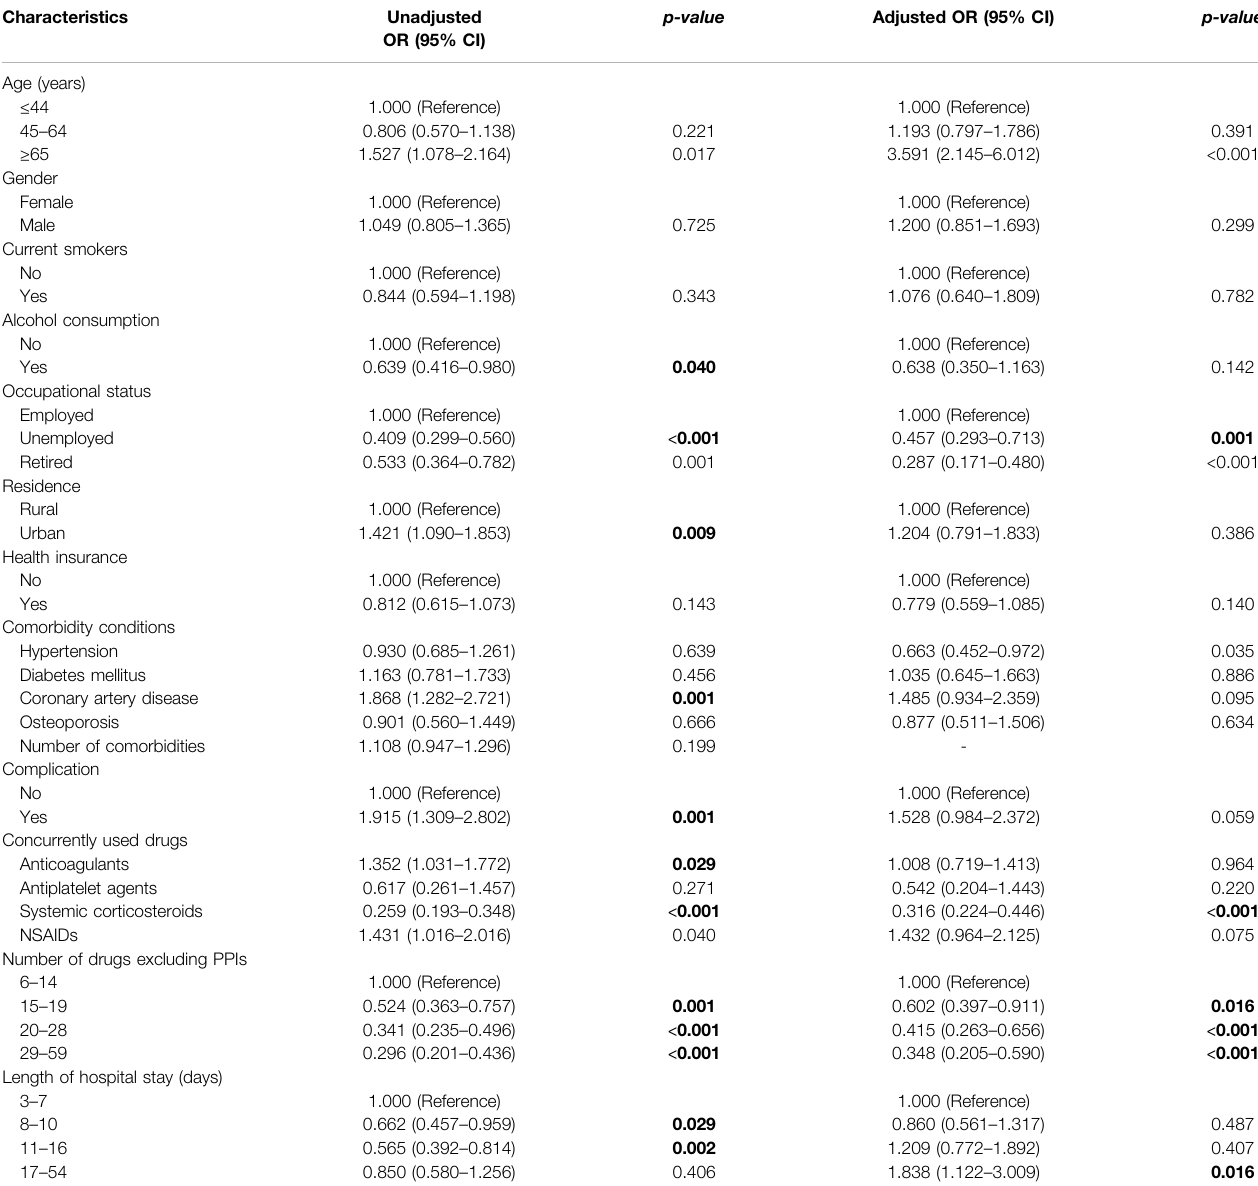
TABLE 7 | Univariate and multivariate logistic regression analyses of factors associated with overprescription of ASMs for SUP.